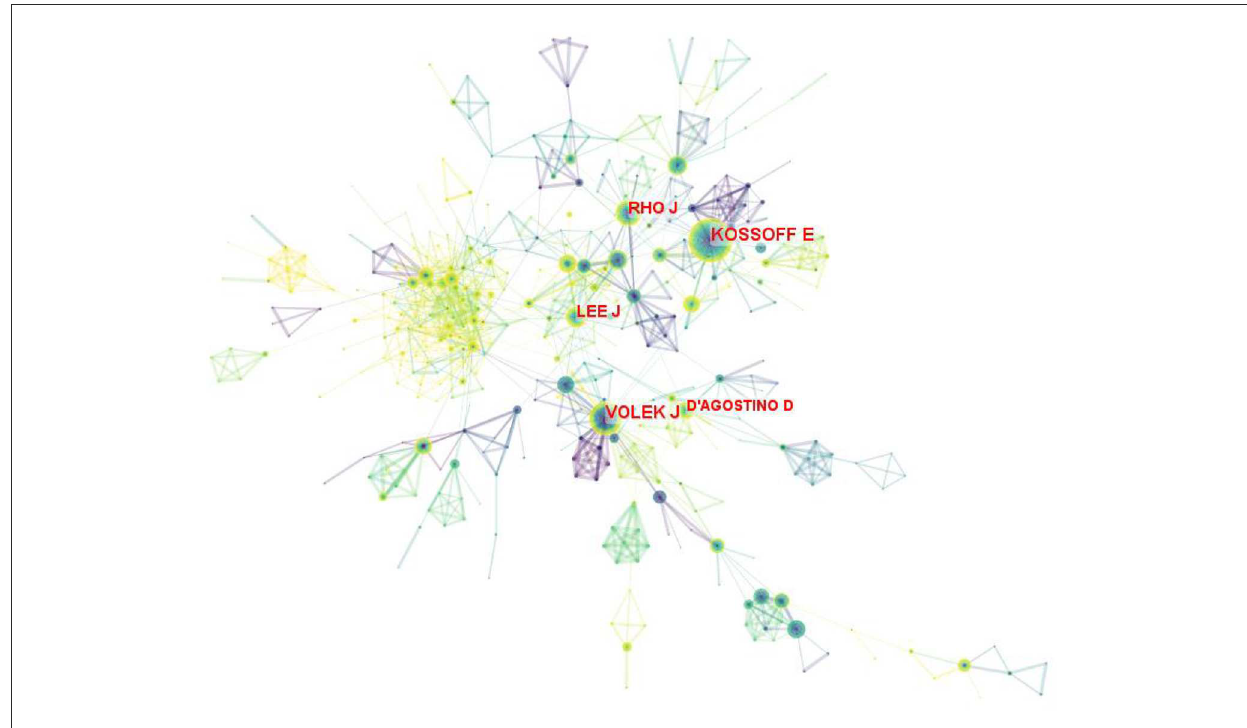
FIGURE5 Map of authors on LChD from 2002 to 2021.